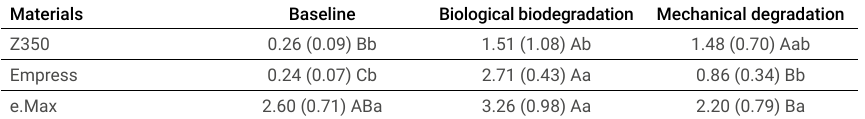
Table 2. Means (standard deviations) of surface roughness (Ra) (µm) for the different experimental conditions. Materials